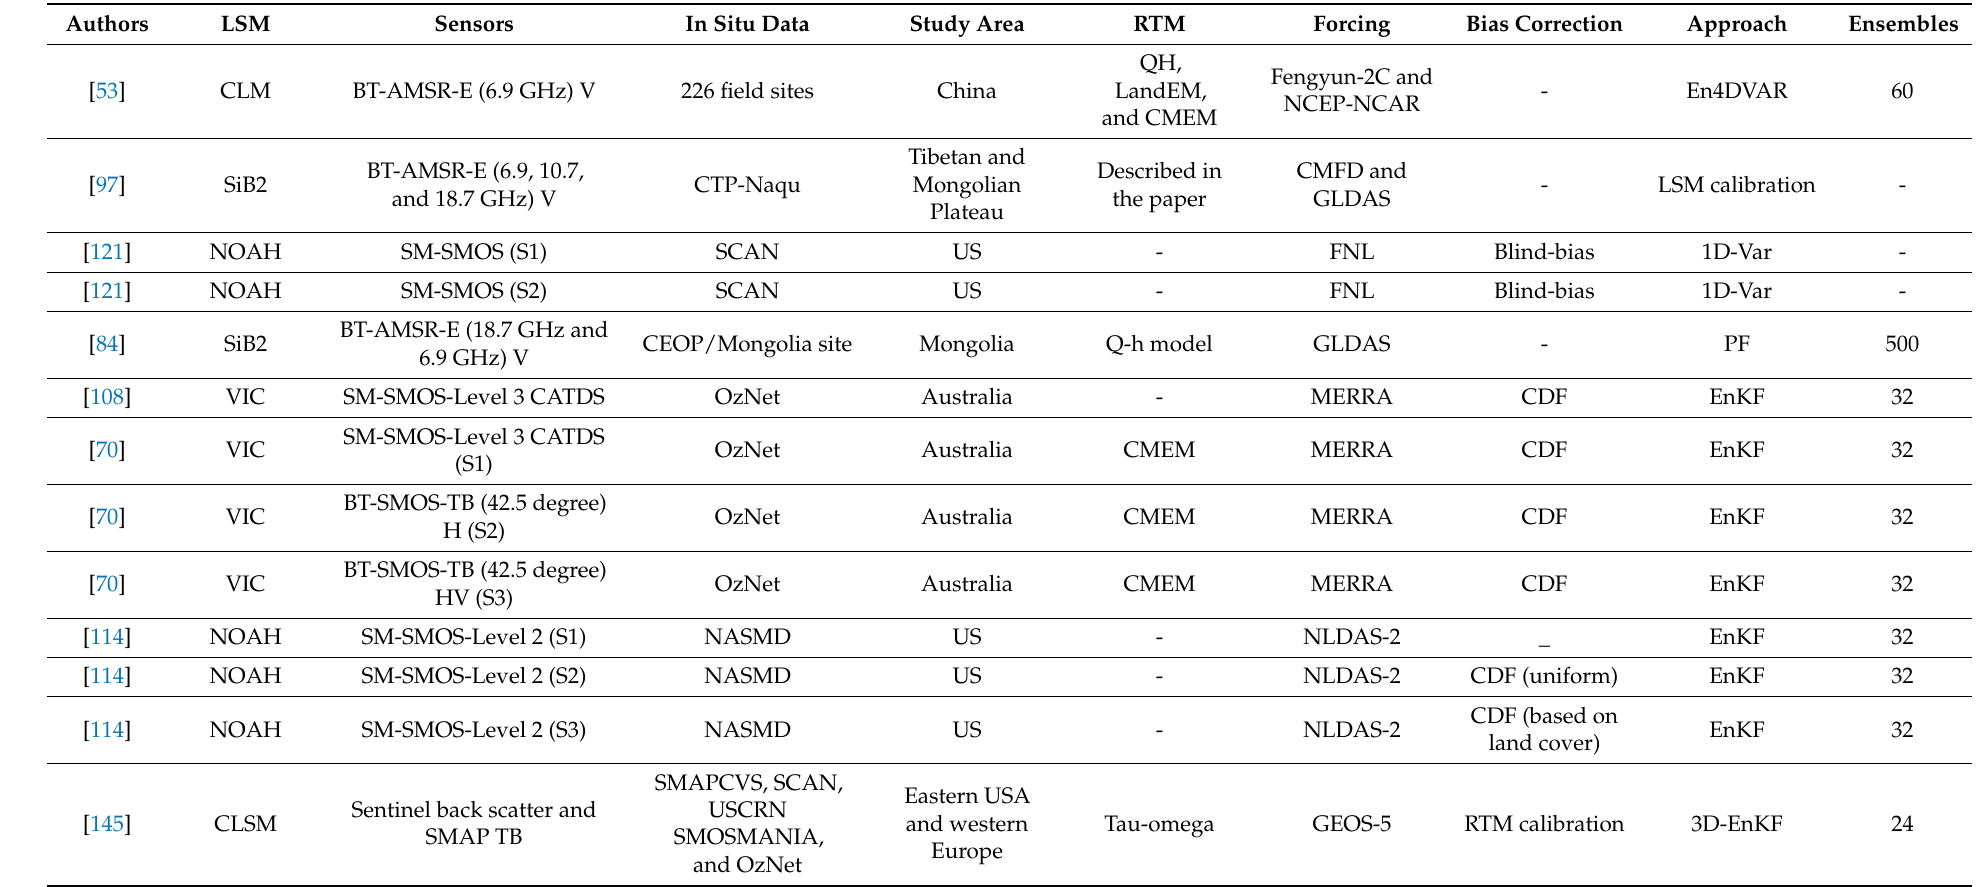
Table 3. Correlation improvements of more than 0.12 for SSM for papers reviewed in this